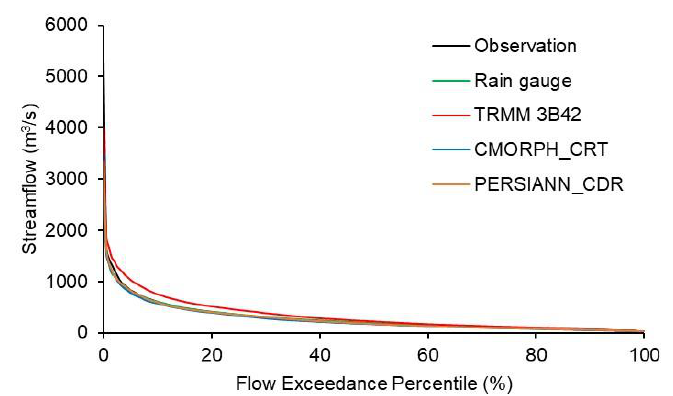
Figure 7. Daily discharge flow duration curves (FDCs) for observations, rain gauge simulation, TRMM